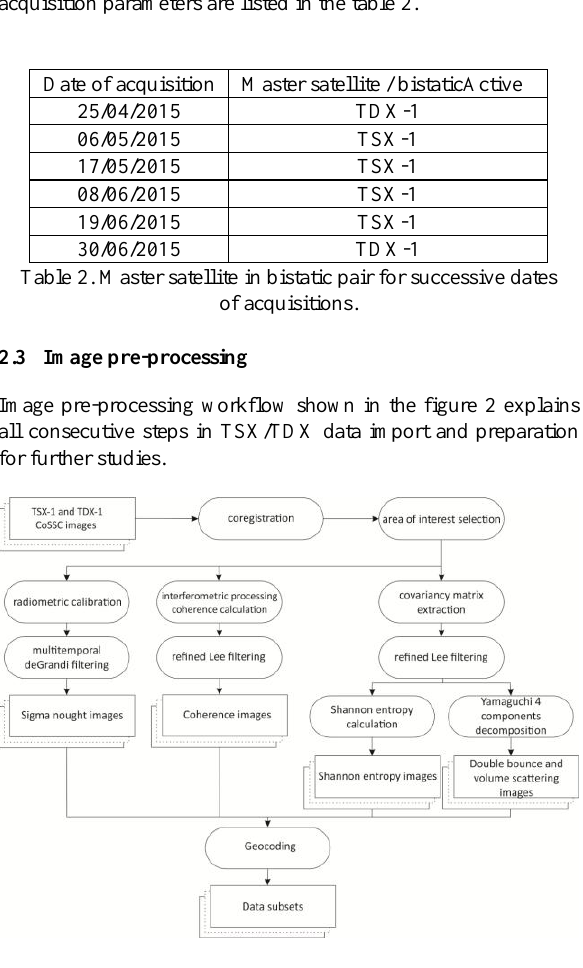
Figure 2. Workflow of TSX/TDX data preprocessing.